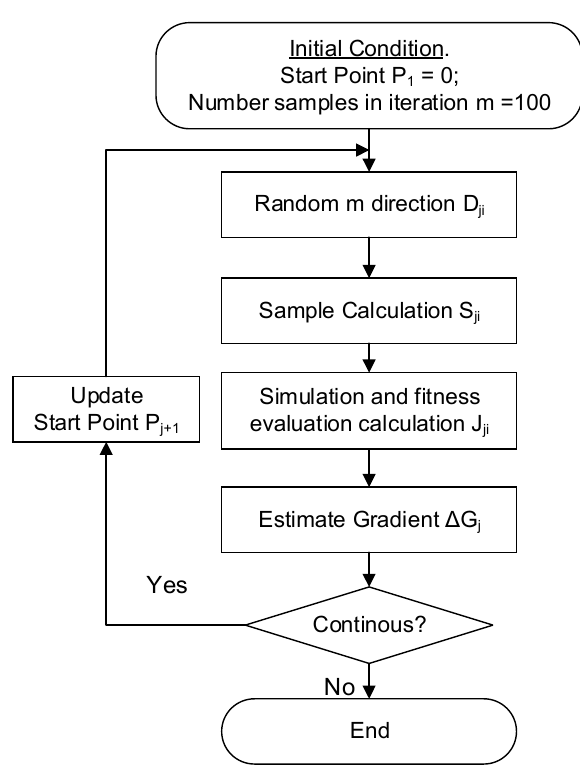
Figure 7. Policy gradient estimation.